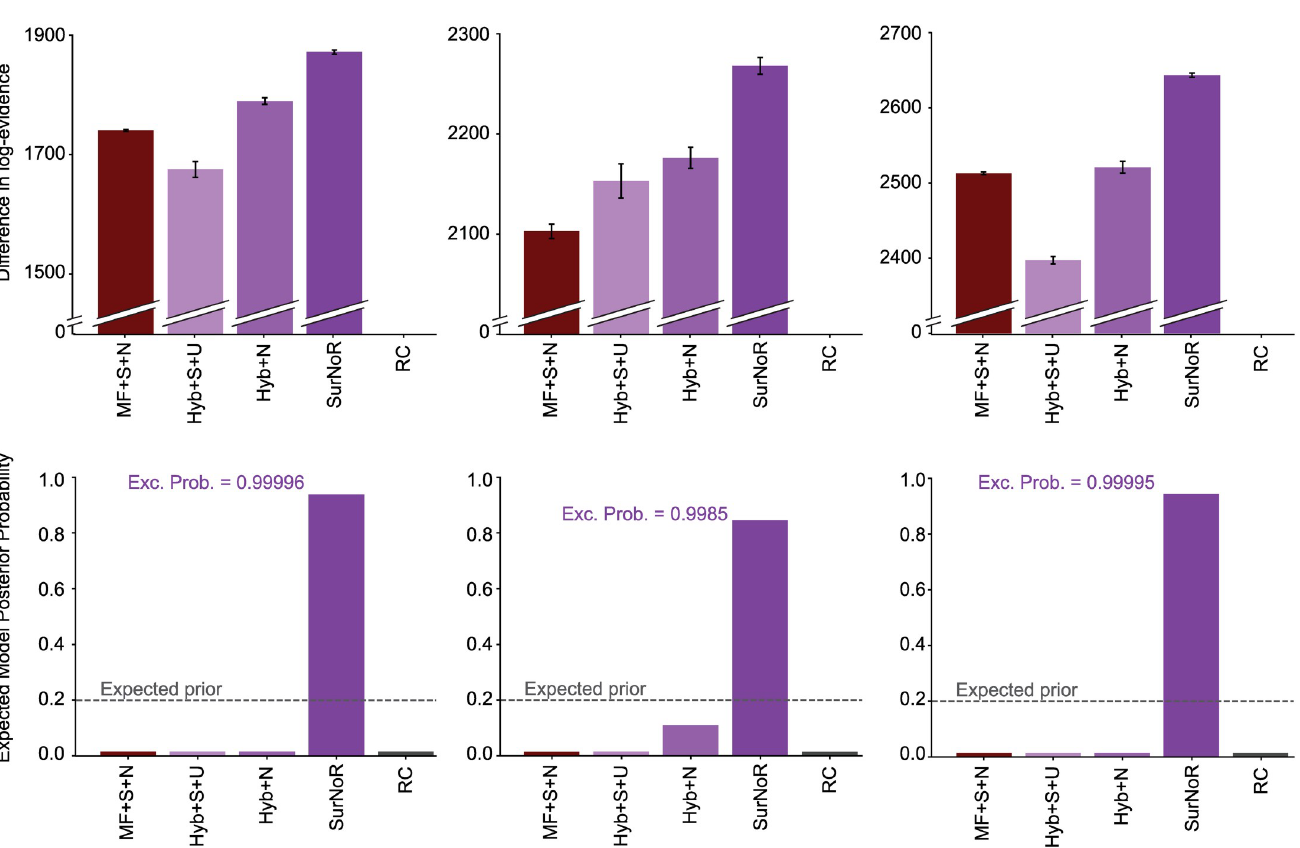
Fig 8. When data is generated by SurNoR, the true model can be recovered. We applied our model-selection method to the data of three sets of 12 simulated participants. The left column corresponds to the data shown in Fig 7, and the middle and the right columns correspond to the data shown in S2 and S3 Figs, respectively. We compared the SurNoR model with the strongest competitors of SurNoR: MF+S+N, Hyb+S+U, and Hyb+N (c.f. Fig 5). A . Difference in log-evidence with respect to random choice (RC) and B . the expected posterior model probability [52, 53] for the algorithms for all episodes of both blocks given the data of each of the three sets (different columns) of 12 simulated participants (c.f. Fig 5A and